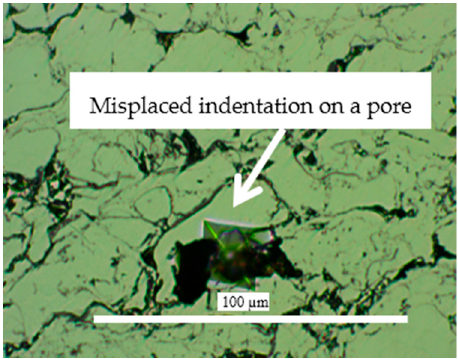
Figure 1. Optical microscopic image of a misplaced microindentation trace on a pore.